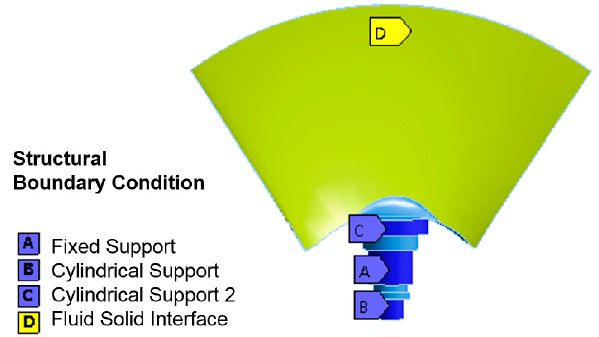
Figure 6. Boundary conditions of structure calculation.